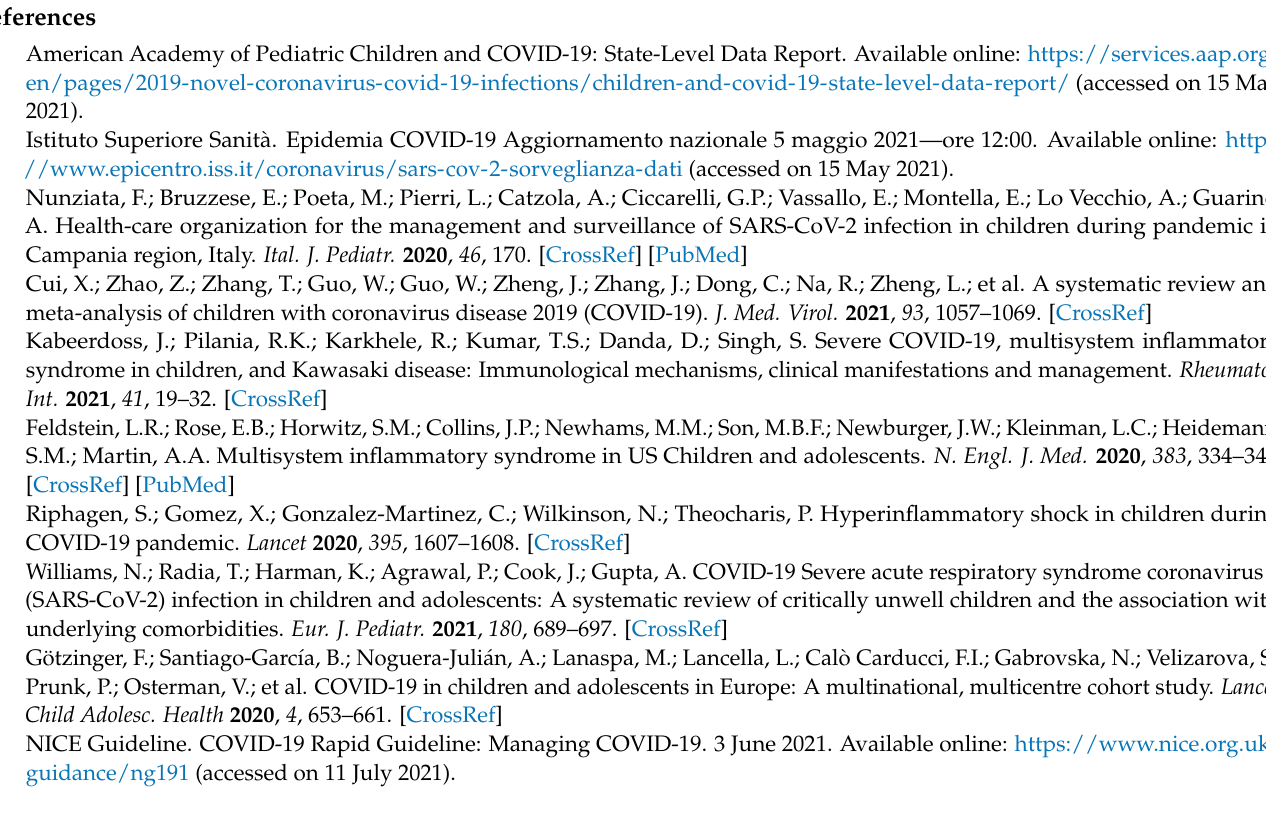
Figure 1. Vaccination in children with allergy to cow’s milk or other foods.